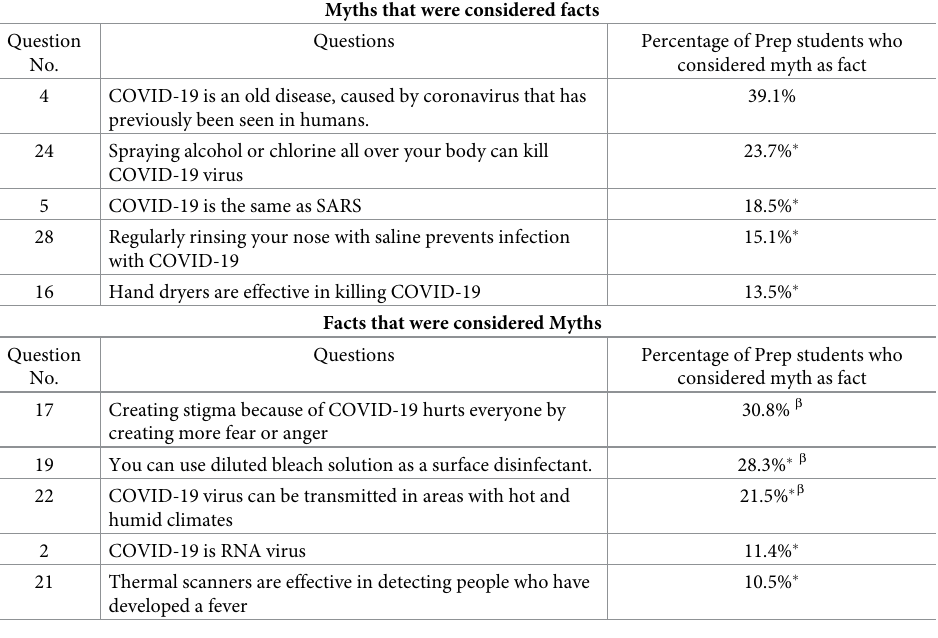
Table 5. Top five Myths that were considered facts and vice versa by preparatory year students. Myths that were considered facts Question